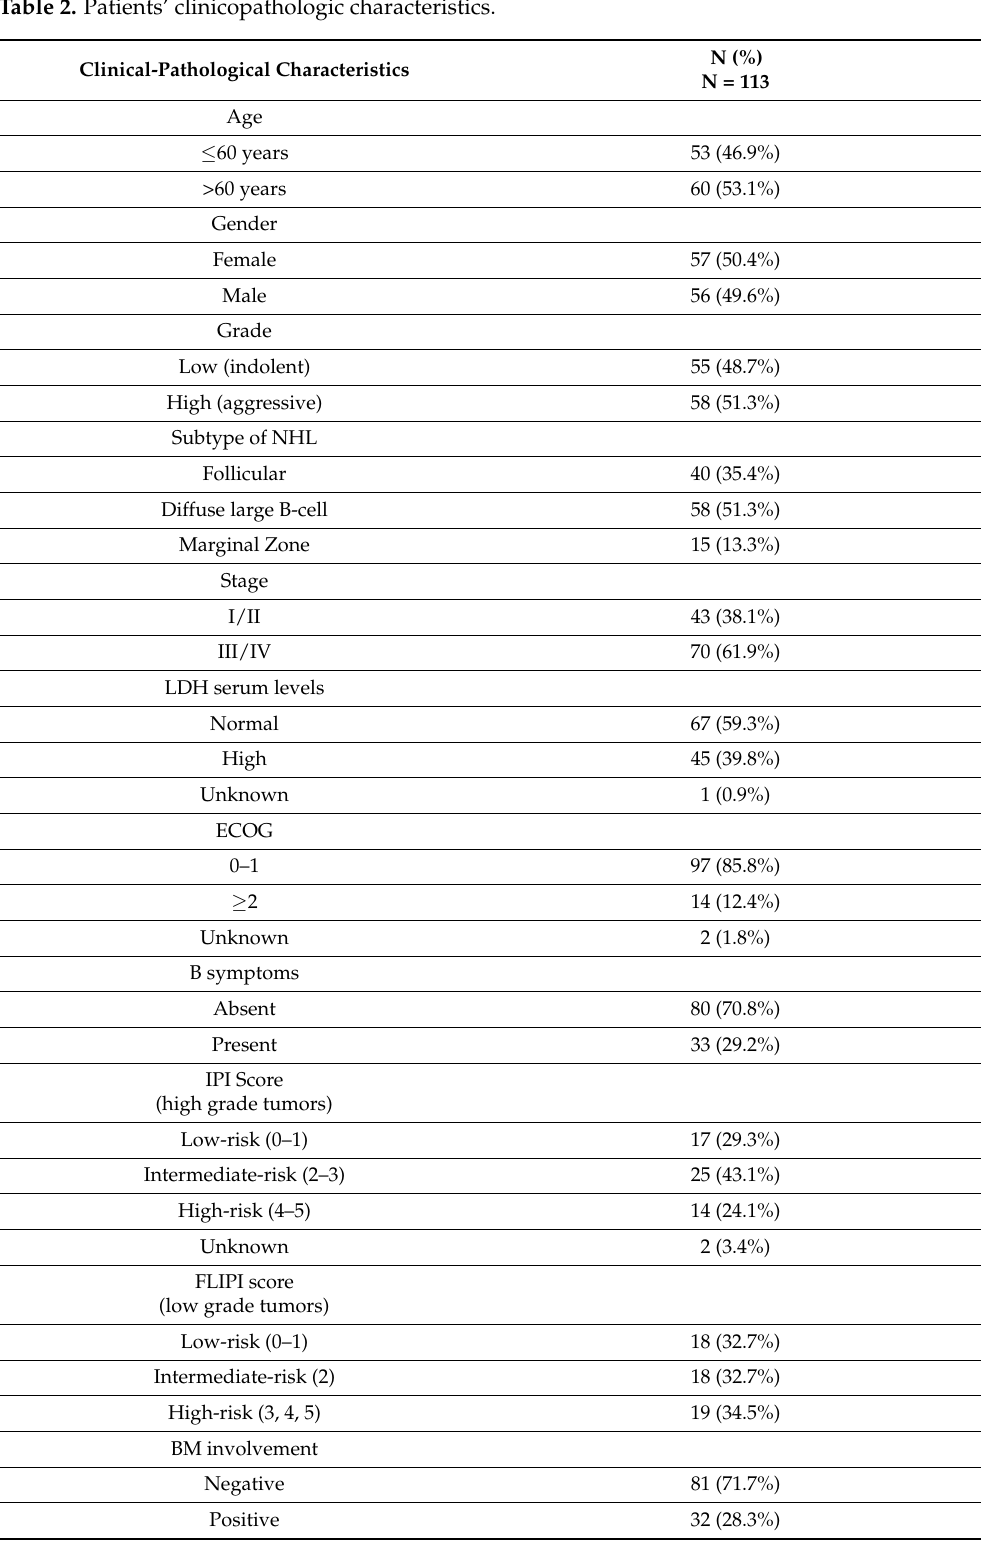
Table 2. Patients’ clinicopathologic